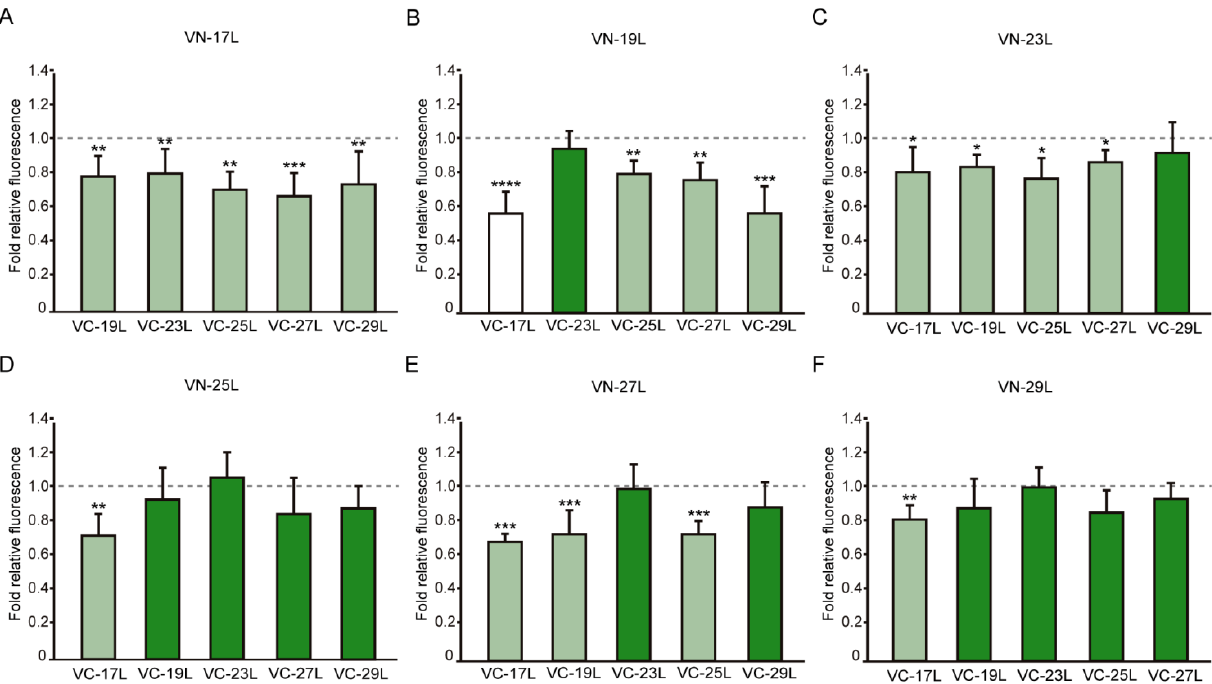
FIGURE 7: Differences in hetero-dimerization in eukaryotic membranes. Mean relative fluorescence of chimera hetero-oligomerization. For any given combination (eg.VN-X/VC-Y) the corresponding homo-oligomerization values (VN-X/VC-X and VN-Y/VC-Y) were used as a reference set to ob- tain fold change and significance (q-values,*<0.05, **<0.01, ***< 0.001, **** <0.0001). (A) VN-17L/VC-X, (B) VN-19L/VC-X, (C) VN-23L/VC-X, (D) VN- 25L/VC-X, (E) VN-27L/VC-X, (F) VN-29L/VC-X. Error bars indicate the standard deviation obtained from at least 4 independent replicates. A color intensity code was used to highlight the dimerization intensity. Dark green (fluorescence values equivalent to the appropriated control), light green (fluorescence values significantly higher than those obtained with the H2 control but significantly lower than those observed with the corresponding homo-oligomer controls), and white (values equivalent to those obtained with the H2